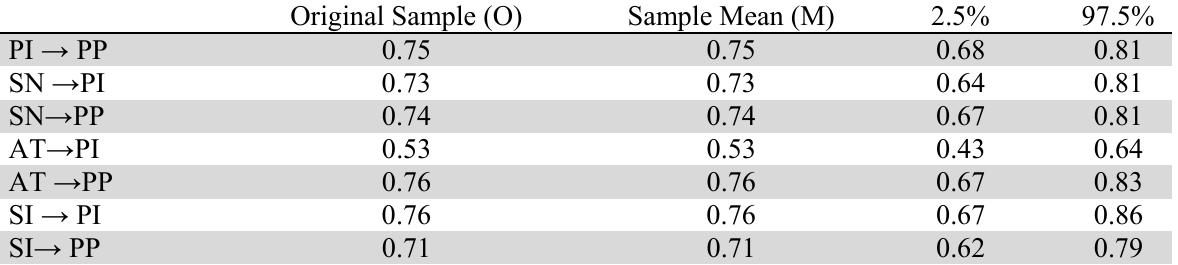
Discriminant validity (heterotrait-monotrait ratio of correlations, HTMT